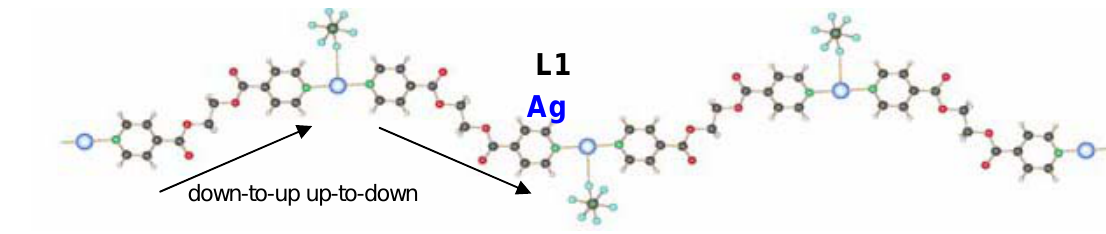
Figure 5. Excerpt of the 1D-chain structure of {[Ag(L